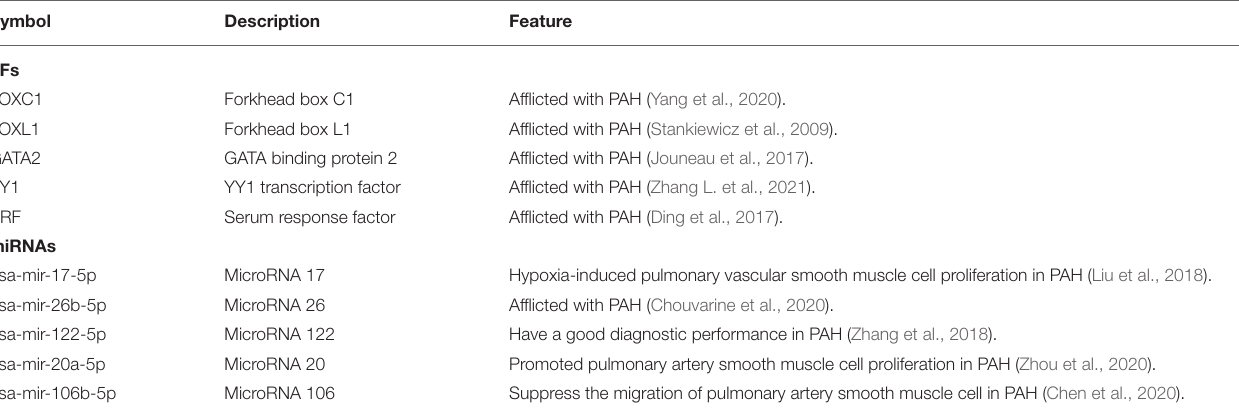
TABLE 4 | Summary of the regulatory biomolecules [transcription factors (TFs), miRNAs] of DEGs in PAH disease identified from the interactions of DEGs with TFs and DEGs with miRNAs. Symbol